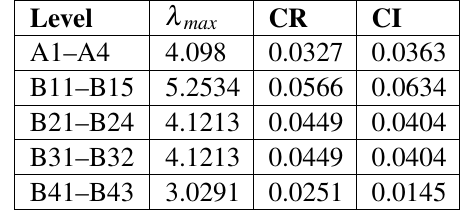
Table 6 Consistency judgment of analytic hierarchy